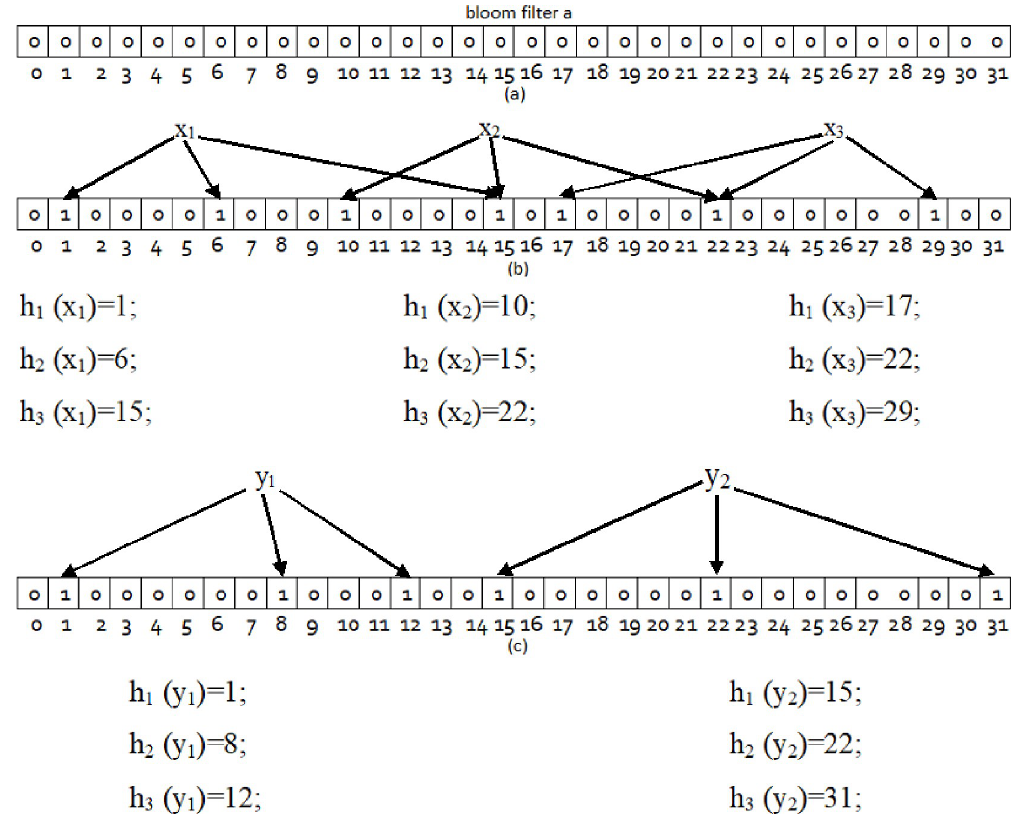
Fig 1. Insert element membership in bloom filter. (a) Initial bloom filter (b) Insert three elements x 1 x 2 and x 3 (c) Query two elements